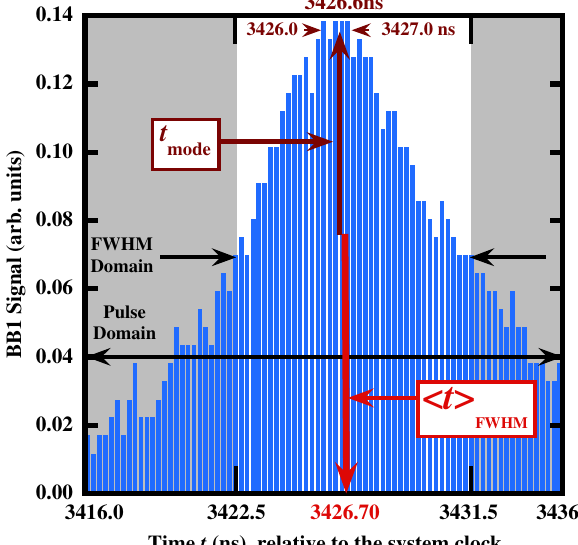
FIG. 9. Comparison of the data pulse for channel bb1 vs the signal smoothed by the Savitzky-Golay digital filter. The peak parameter t is thus calculated from the entire raw signal. smoo Arbitrarily defined subdomains (noise, pulse, and FWHM) are indicated.